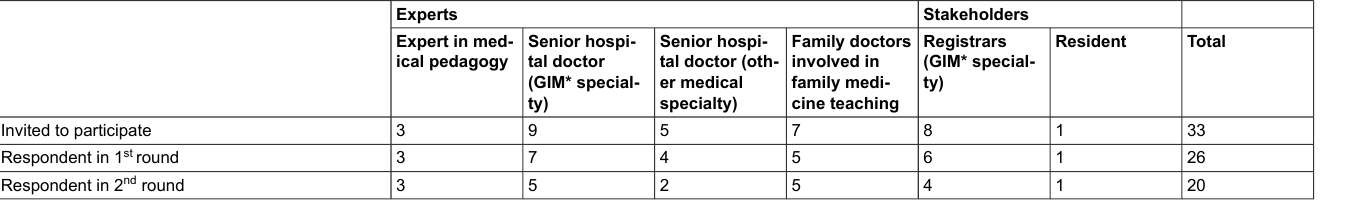
Table 2: Profile of invited participants (modified Delphi method).